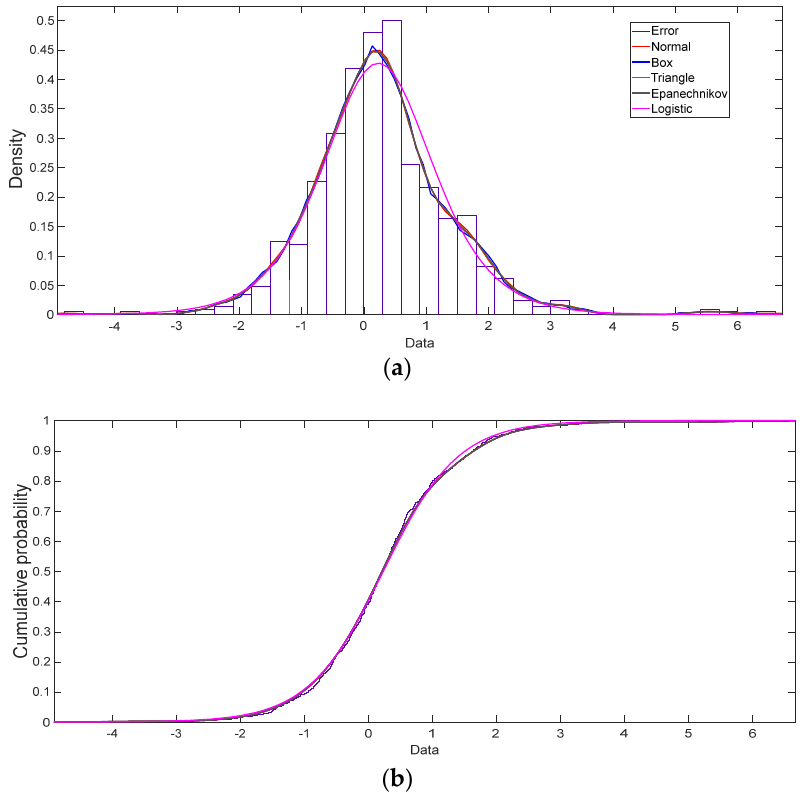
Figure 4. 0–1750 MW interval training set error; ( a ) probability density function curve; ( b ) cumulative distribution function curve.